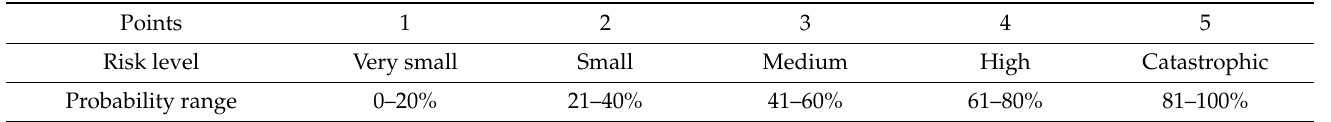
Table 2. Point-based assessment of the probability of a given